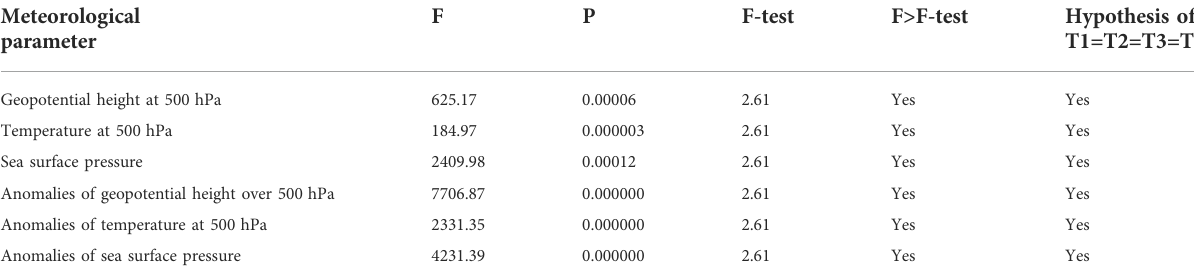
TABLE 1 Results from